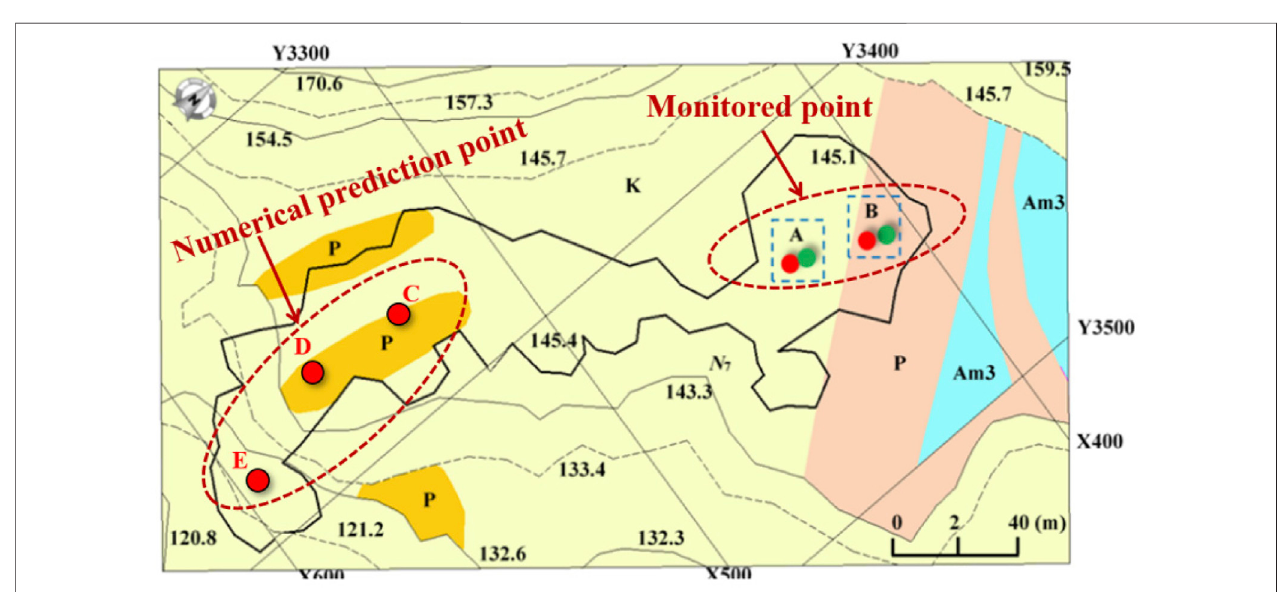
FIGURE 8 | Relative position relationship between monitoring points and numerical simulation prediction points in goaf.